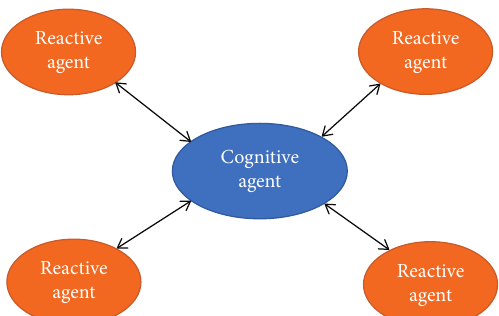
Figure 6: Centralized multiagent architecture. This diagram shows the two types of agents who are responsible for communicating in control architecture, the same as in Figure